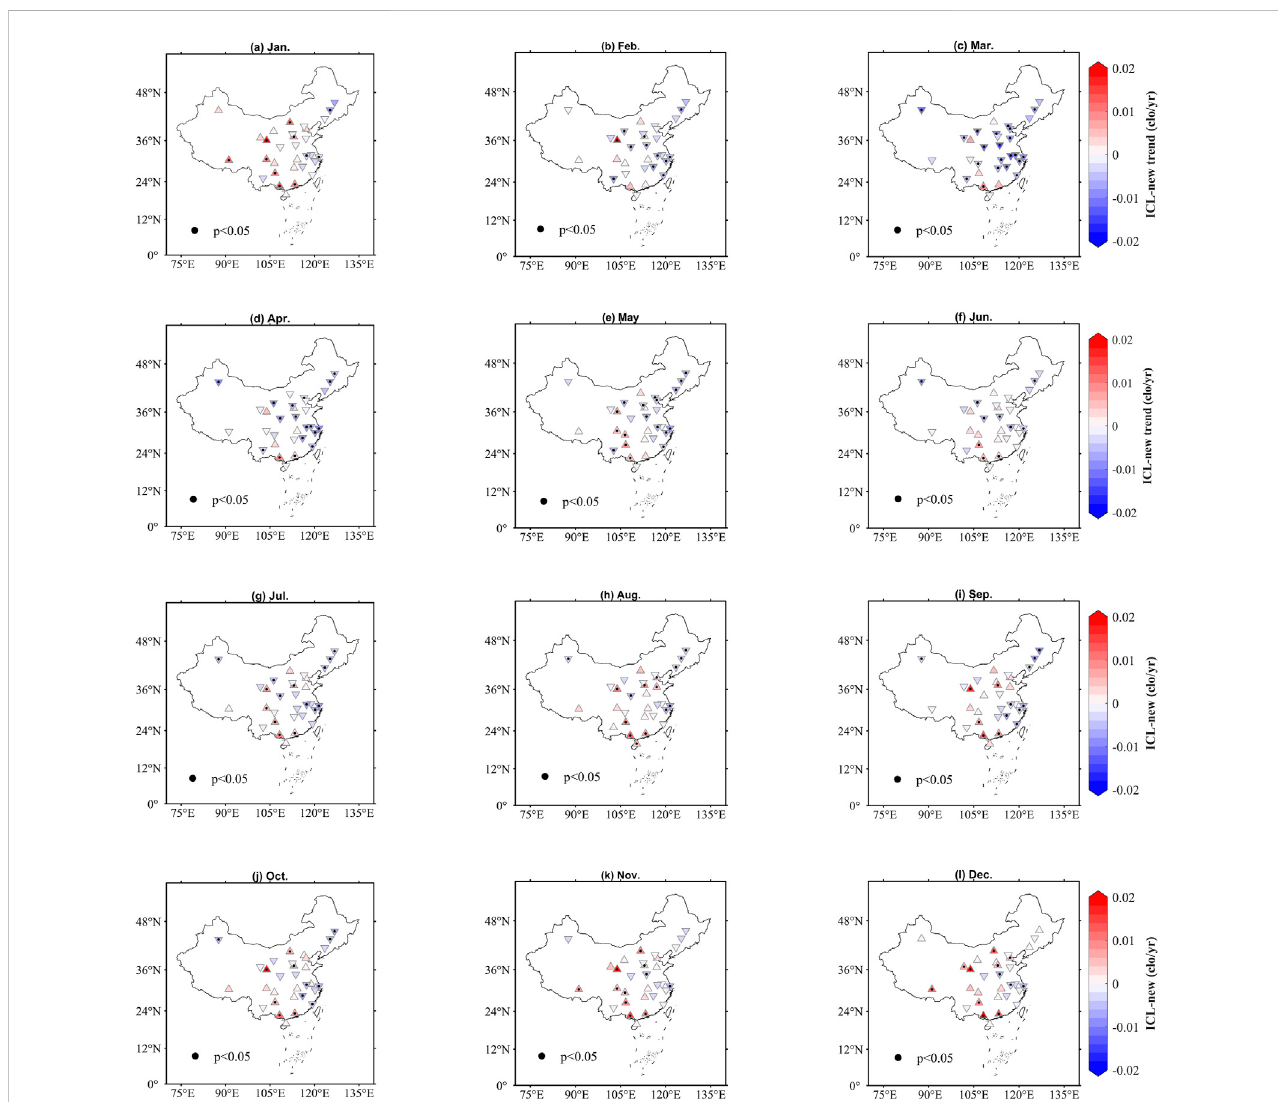
FIGURE 5 Spatial distribution of monthly changes of ICL-new during 1980 – 2019, the positive triangle indicates an upward trend, the inverted triangle indicates a decreasing trend, and the black dots indicate that the change in theICL was signi fi cant at p = .05 level. Labels (A – L) represent January, February, March, April, May, June, July, August, September, October, November, December,